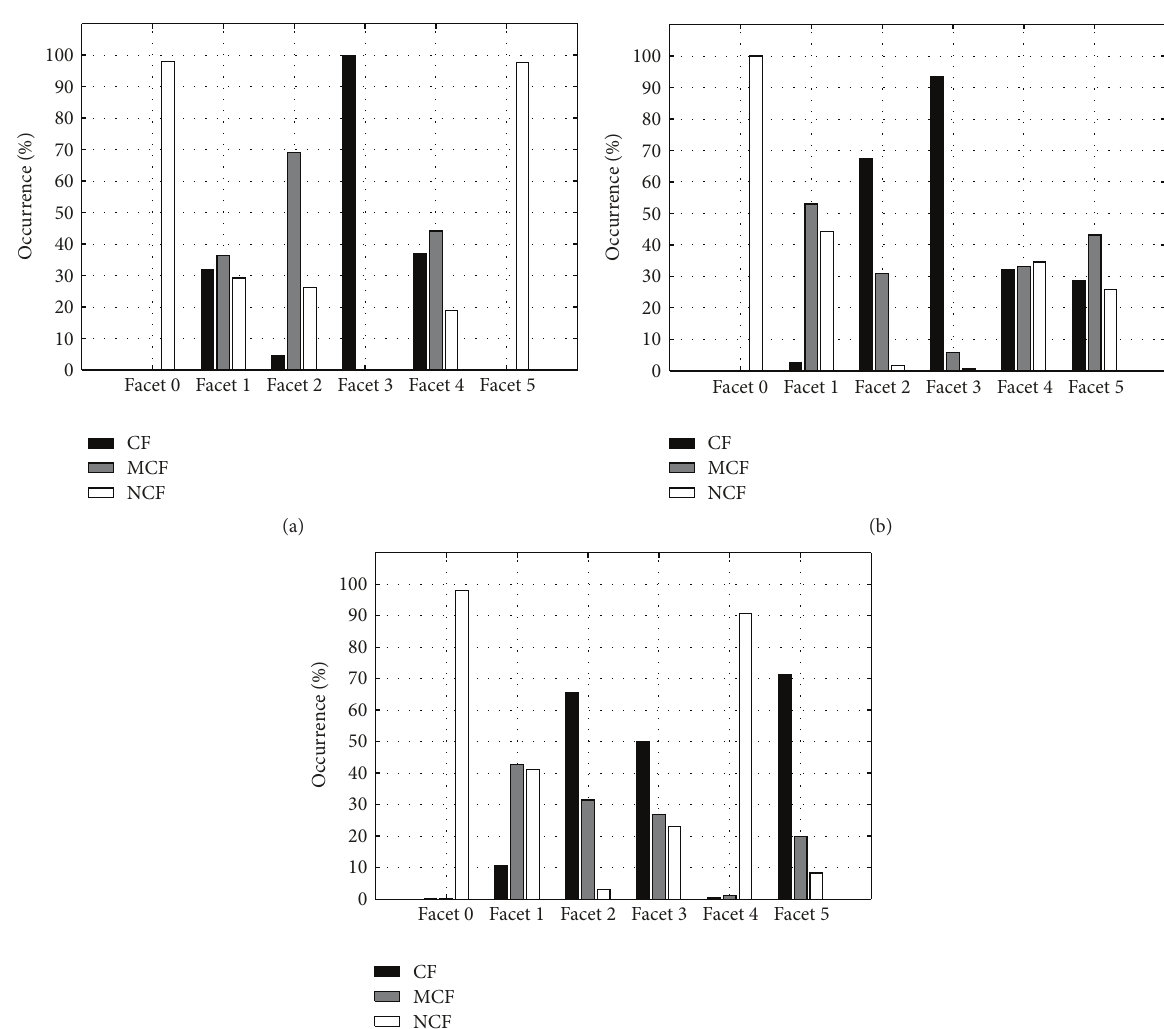
Figure 6: Identification of contribution degree of the facets in (a) the first zone, (b) the second zone, and (c) the third zone.